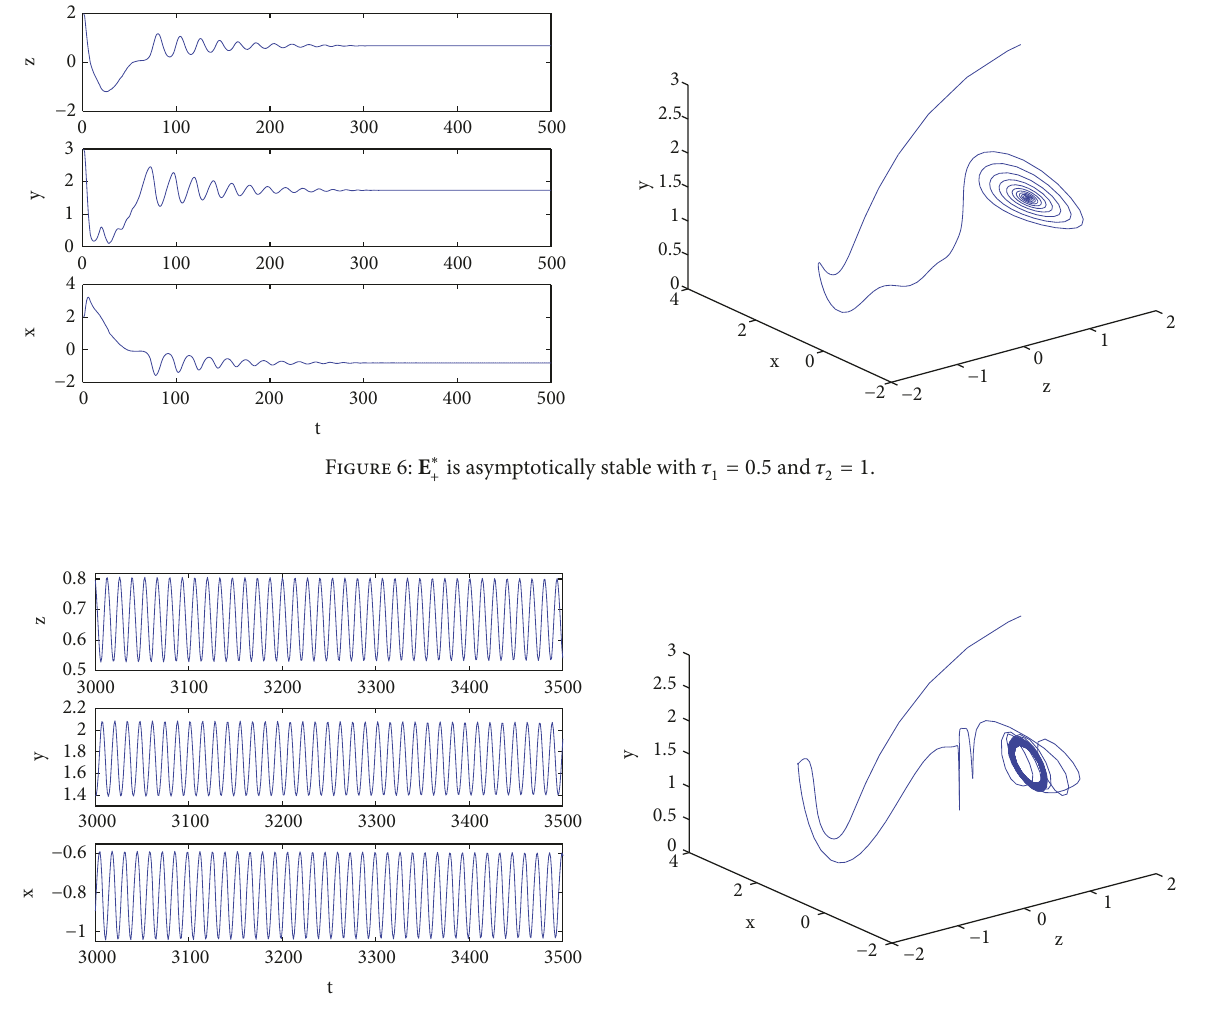
Figure 7: E ∗ + is unstable, and a periodic solution appears with 𝜏 1 = 0.5 and 𝜏 2 = 5.8 .